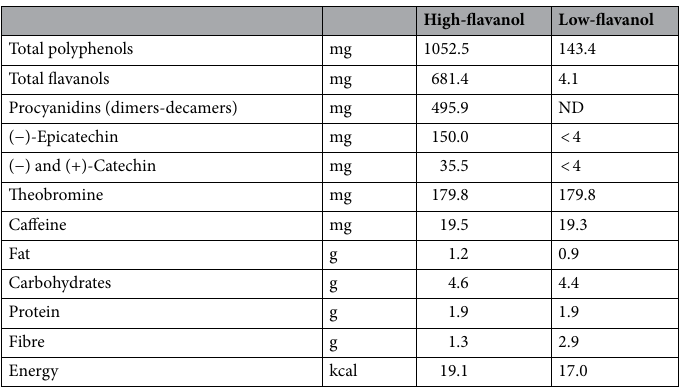
Table 2. Composition of cocoa interventions (8.3 g per individual dose) containing high and low flavanol content used in the acute